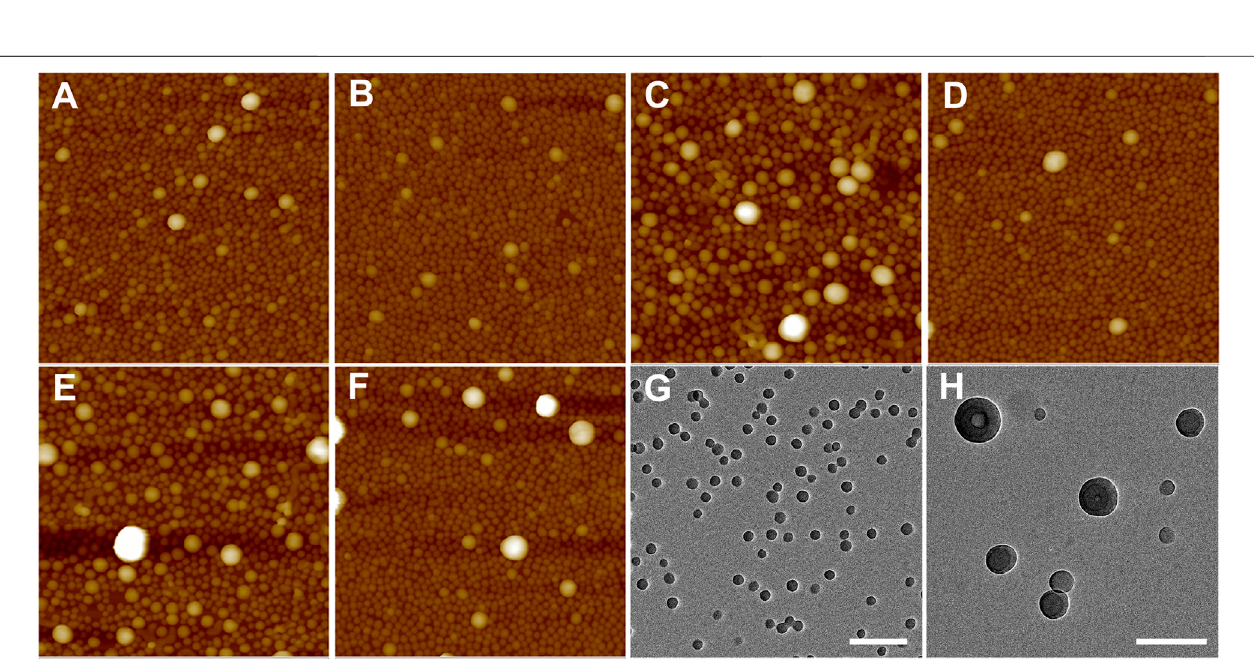
FIGURE 6 | (A – F) AFM height images (2 μ m × 2 µm) of mixtures of (A) S2T3-1, (B) S2T3-2, (C) S2T3-3, (D) S2T3-4, (E) S2T3-5, and (F) S2T3-6. The Z scale for (A – F) is 200 nm. (G,H) TEM images of mixtures of (G) S2T3-2, and (H) S2T3-3. The scale bar in (G,H) is 200 nm. The mixture IDs are corresponding to the IDs